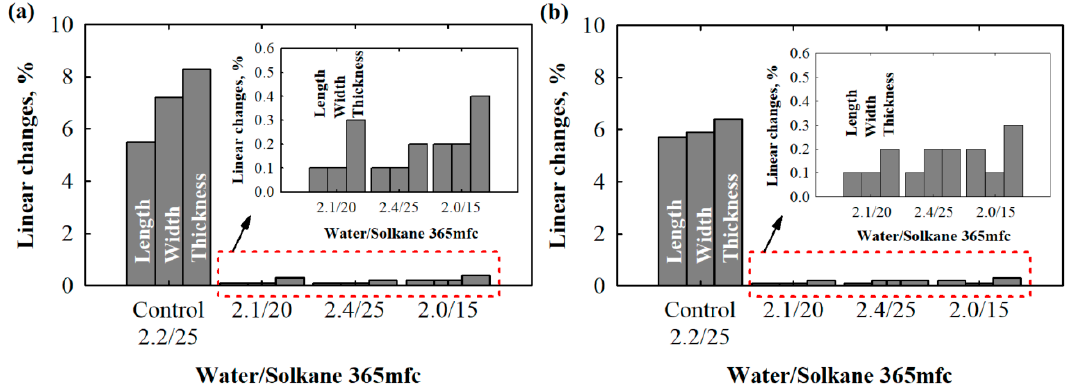
Figure 4. Linear changes after treatment at 70 °C and 90% relative humidity: ( a ) 40 kg/m 3 and ( b ) 30 kg/m 3 .